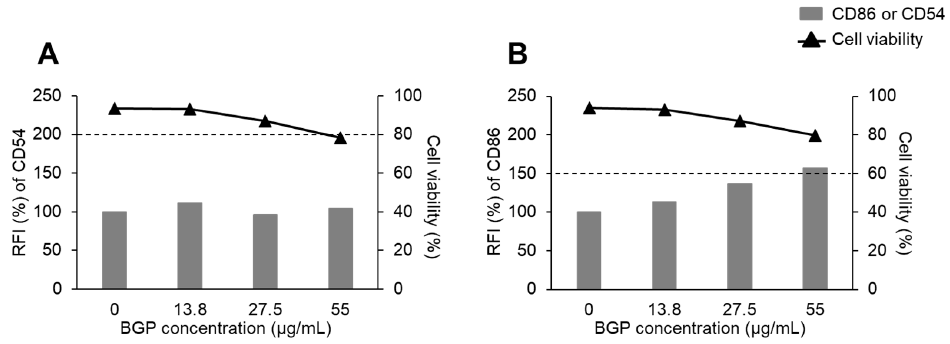
Figure 3. Viability of and expression of CD54 and CD86 on the cell surface of DC2.4 cells treated with Brazilian green propolis (BGP). The expression of CD54 ( A ) and CD86 ( B ) was measured by flow cytometry, and the relative fluorescence intensity (RFI) values were calculated. The data at each concentration were obtained from a single culture. Dashed lines indicate RFI values of 200% (CD54) or 150% (CD86).